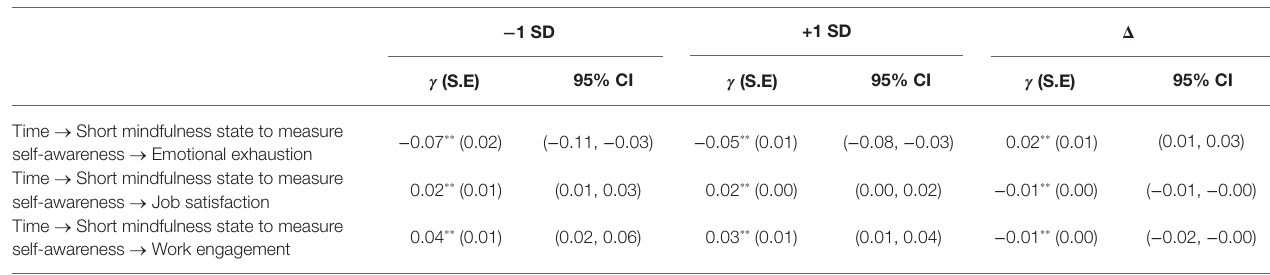
TABLE 3 | Indirect effects.